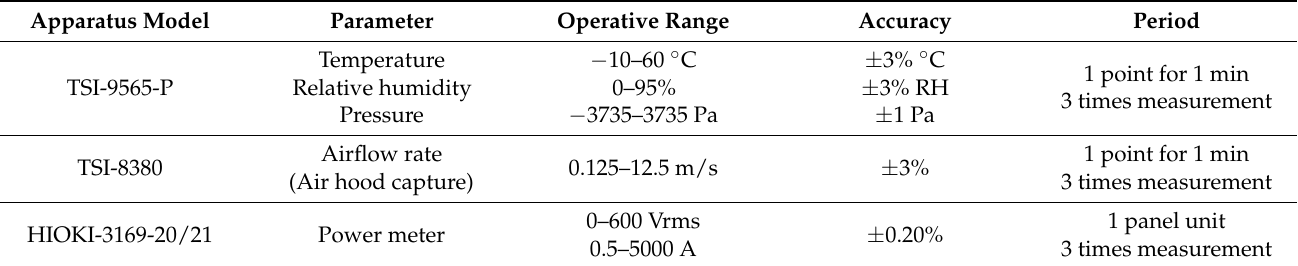
Table 2. Apparatus for field measurements.